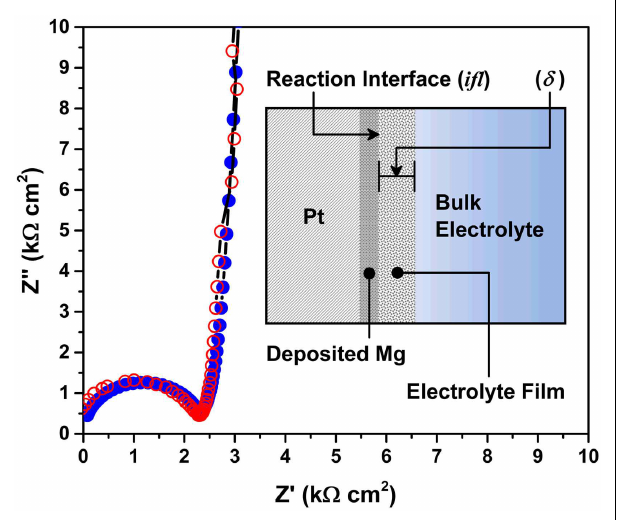
FIGURE 9 | Nyquist plots of the Mg/Pt cell in the EtMgCl-Et 2 AlCl/THF solution as an electrolyte . Unshaded and shaded circles denote the measured and predicted plots, respectively. Inset figure shows the schematic of the model for Mg/electrolyte interface.